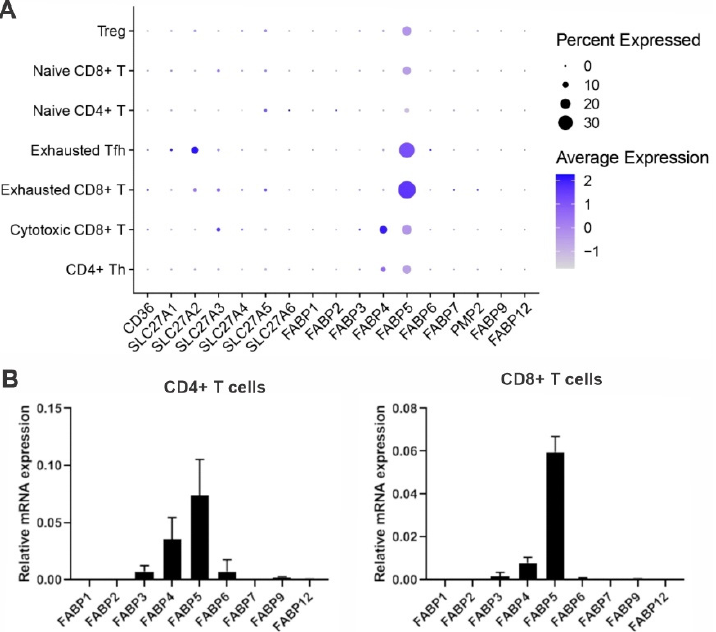
Figure 3. Expression profile of FABP family members in T cells. ( A ) Analysis of the expression profile of fatty acid uptake related genes, including CD36, fatty acid transport protein 1-6 (FATP 1-6, encoded by SLC27A1-6) and FABP family members, in different T cell subsets using a publicly accessible dataset GSE131907. ( B ) Expression of FABP family members in naïve CD4 + and CD8 + T cells. Naïve CD4 + and CD8 + T cells were purified from the spleen of C57 BL/6 mice using a flow sorter. RNA was extracted for real ‐ time PCR analysis of FABP family members.